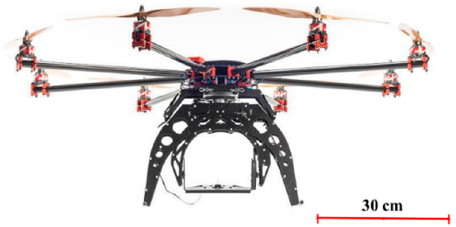
Figure 6. Scaled image that illustrates the actual size of the octocopter Steadi Drone EI8HT RTF that was used for the acquisition of aerial images.